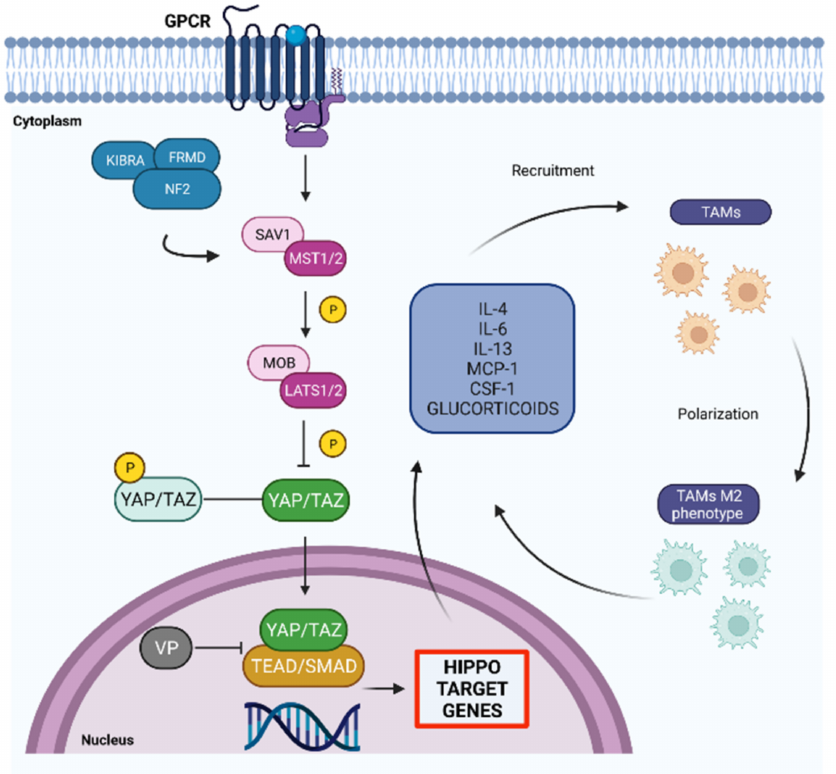
Figure 1. TAMs recruitment and polarization from M1 to M2 are triggered by the Hippo pathway. Nuclear localization of YAP/TAZ promote the activation of a large amount of inflammatory cytokines which attract TAMs. The M2 phenotype polarization cause migration, proliferation and favor TAMs recruitment. Created with